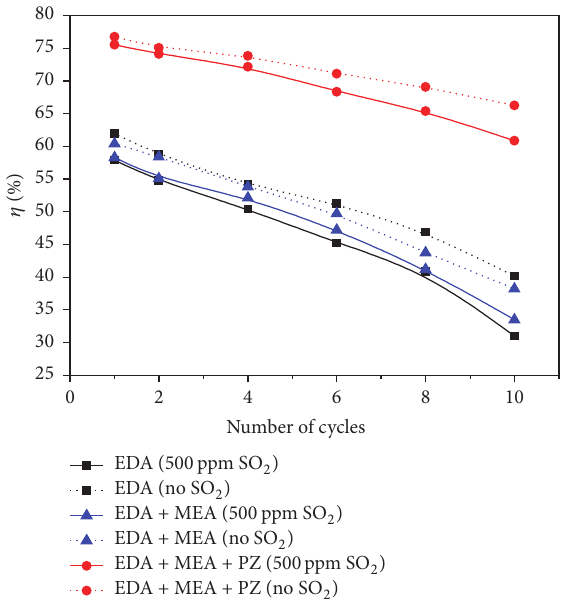
Figure 5: Influence of cycle absorption and desorption on the CO 2 mass transfer rate ( 𝑈 𝑔 = 4m 3 /h, U